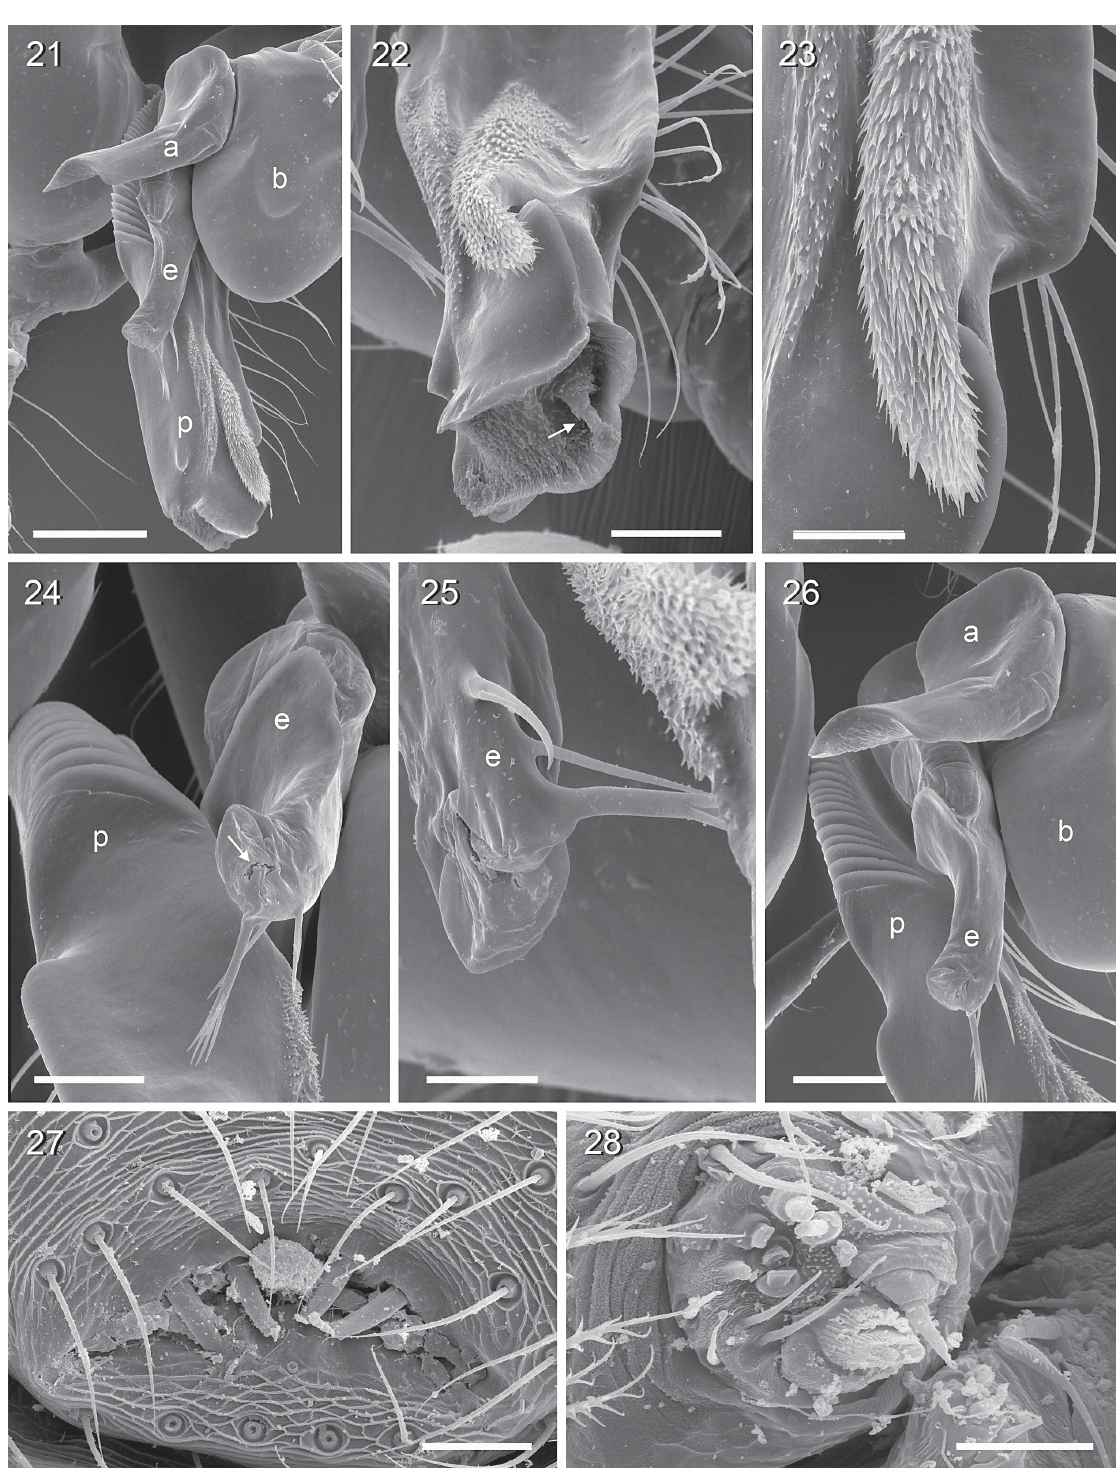
Figs 21–28. Panjange pueh Huber, sp. nov. (ZFMK Ar 14576). 21 . Left procursus and bulb, prolateral view. 22 . Left procursus, prolateral distal view (arrow points to distinctive process in distal pit). 23 . Prolateral membranous process on left procursus. 24–25 . Tip of embolus, distal views. 26 . Left procursus and bulb, prolatero-distal view. 27 . Male gonopore. 28 . Male ALS. Abbreviations: a = appendix; b = genital bulb; e = embolus; p = procursus. Scale lines: 20 µm (28); 30 µm (25, 27); 40 µm (23); 60 µm (22, 24); 100 µm (26); 200 µm